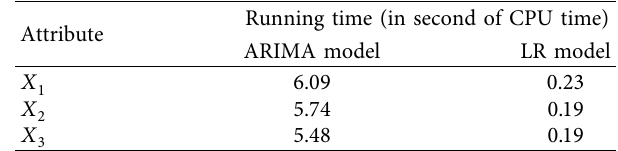
Figure 4: Scatter plot and Q-Q plot of residuals issued by LR model for (a) X Table 4: Comparison of MAPE for ARIMA and LR models. Table 5: Comparison of running time for ARIMA and LR